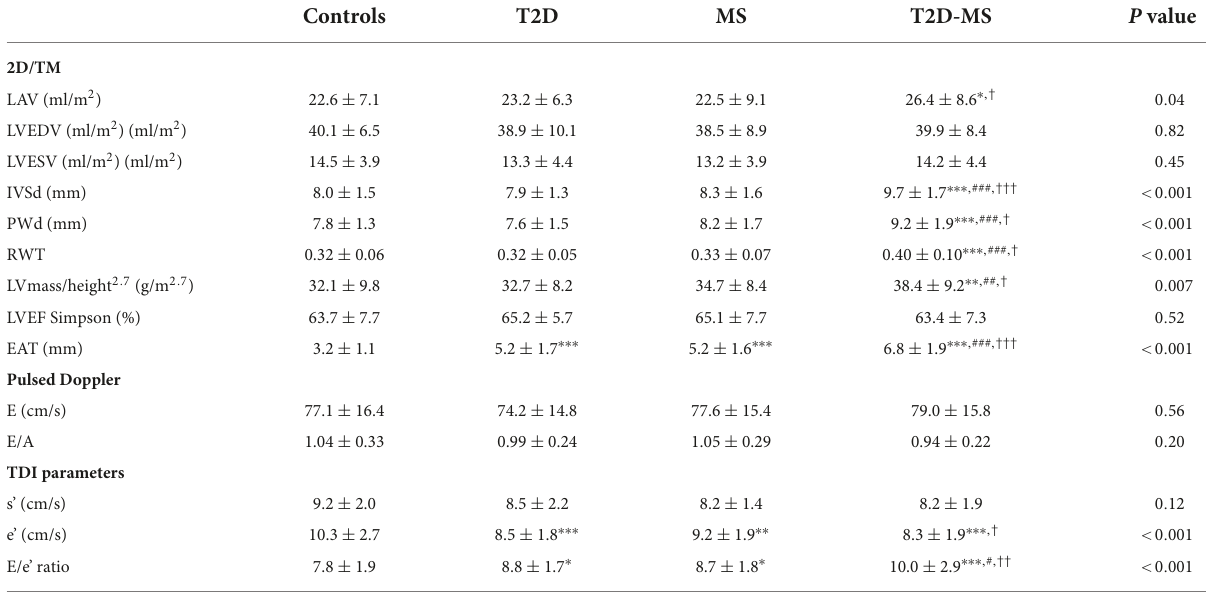
TABLE 2 Echocardiographic